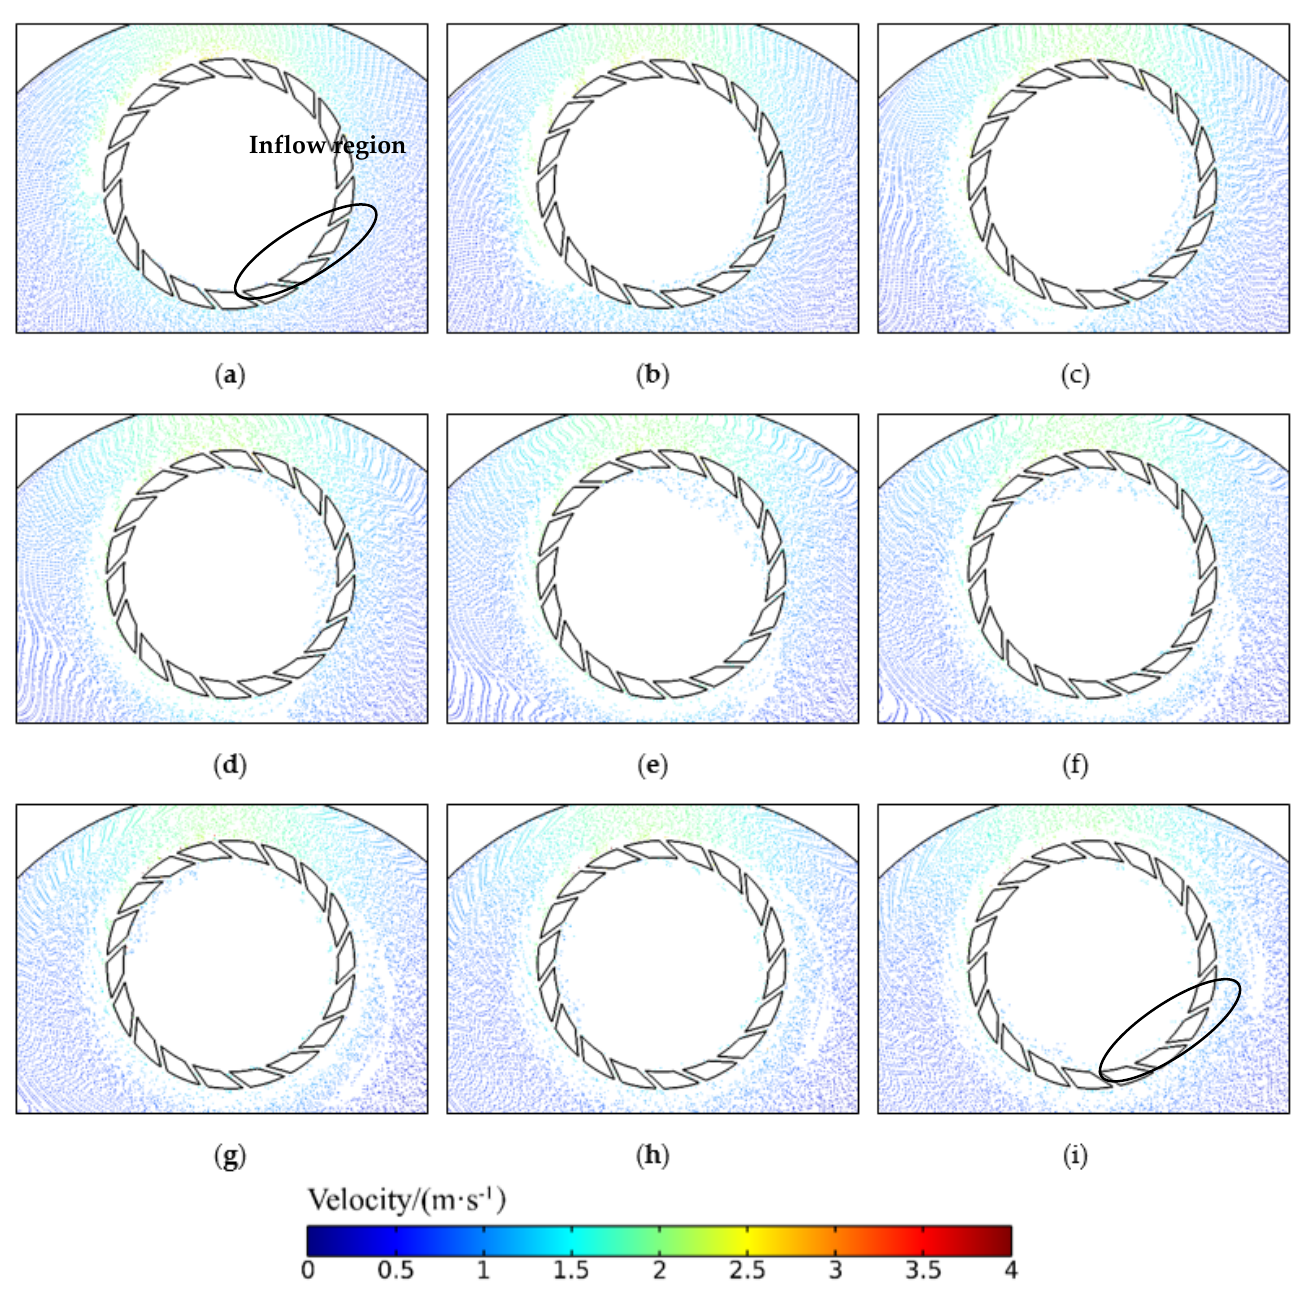
Figure 9. Abrasive entry and exit at different times: ( a ) 0.1 s, ( b ) 0.2 s, ( c ) 0.3 s, ( d ) 0.4 s, ( e ) 0.5 s, ( f ) 0.6 s, ( g ) 0.7 s, ( h ) 0.8 s, ( i ) 0.9 s.